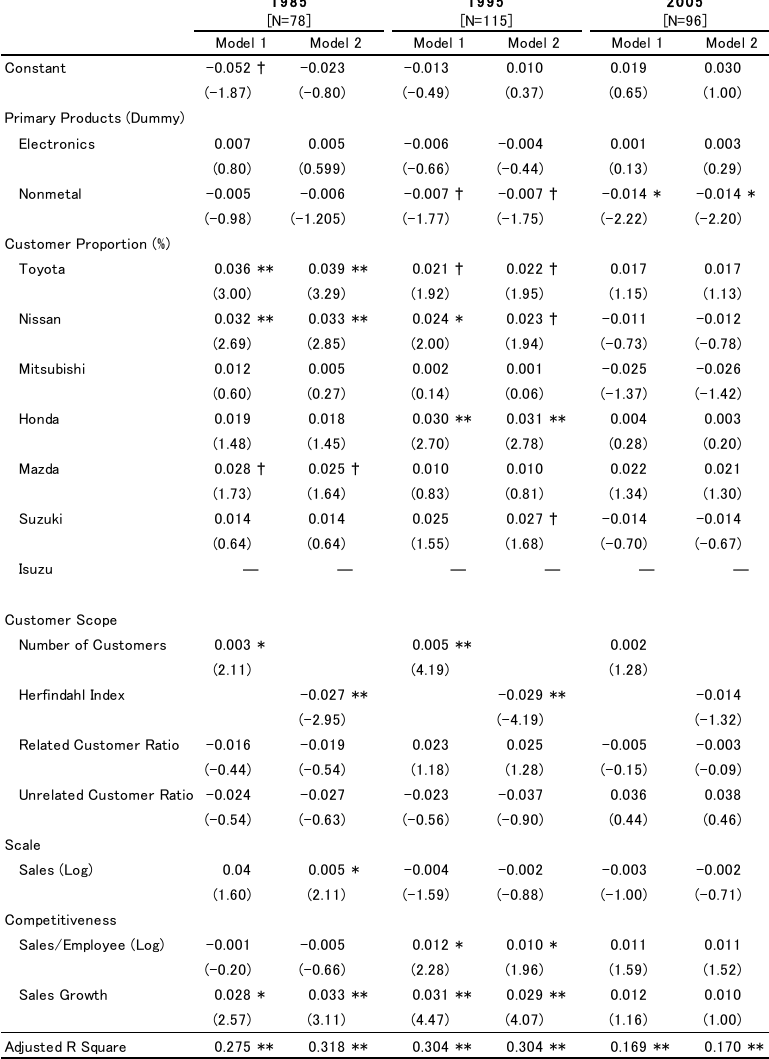
Table 4. Regression analyses (Dependent variable: Profit–sales